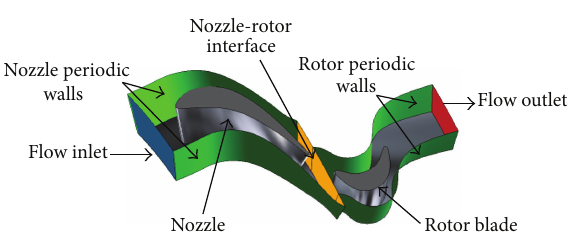
Figure 4: Flow channel geometry and boundary conditions.